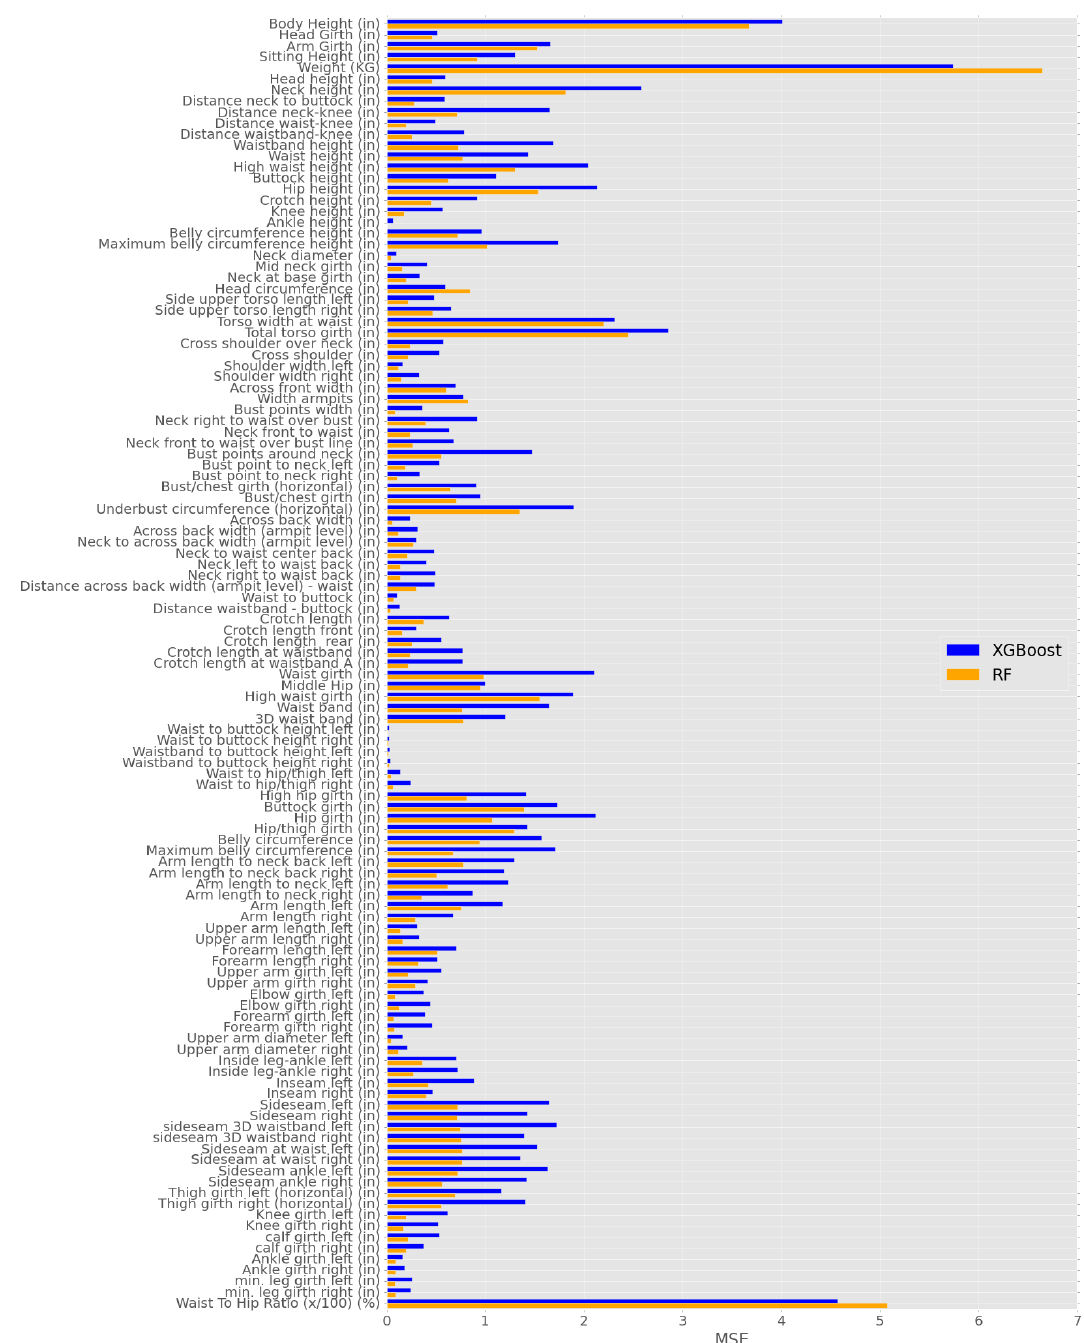
Figure 6. MSE results of XGBoost and RF with Optimal hyper-parameter via Bayesian